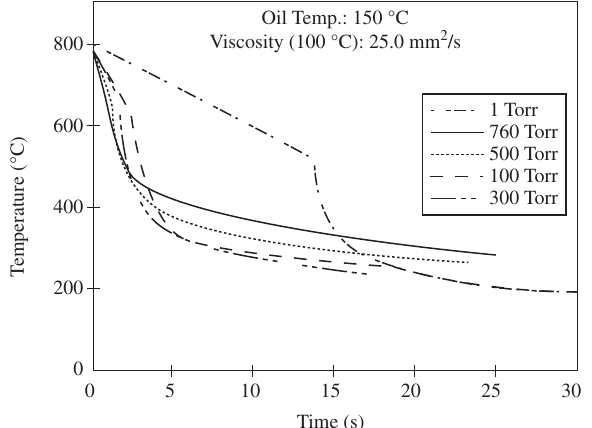
Figure 11. Cooling curve performance of a martempering oil under reduced pressure using the JIS K 2242 cooling curve analysis